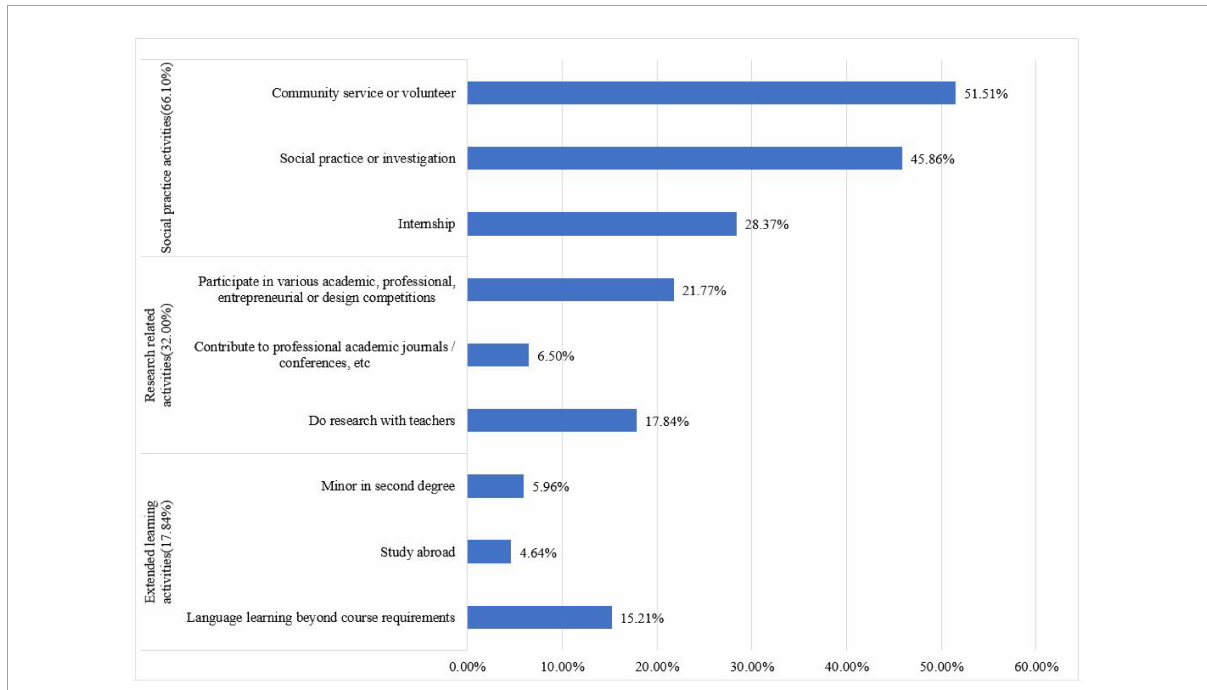
FIGURE2 Overall situation of undergraduates participating in high impact education